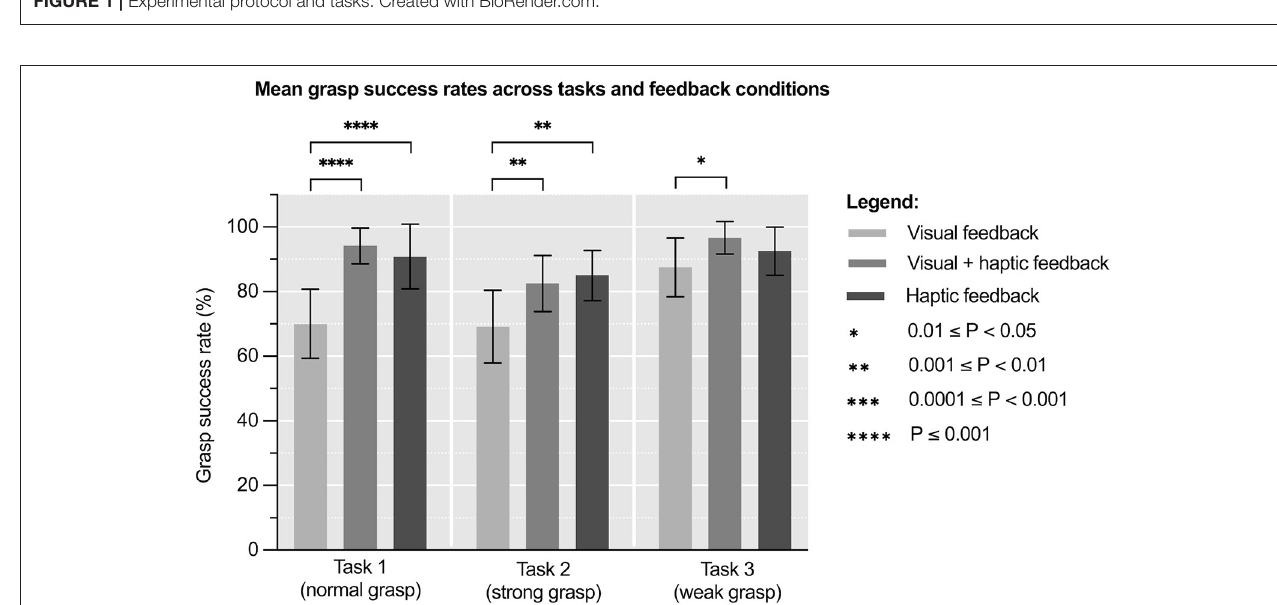
FIGURE 1 | Experimental protocol and tasks. Created with BioRender.com.